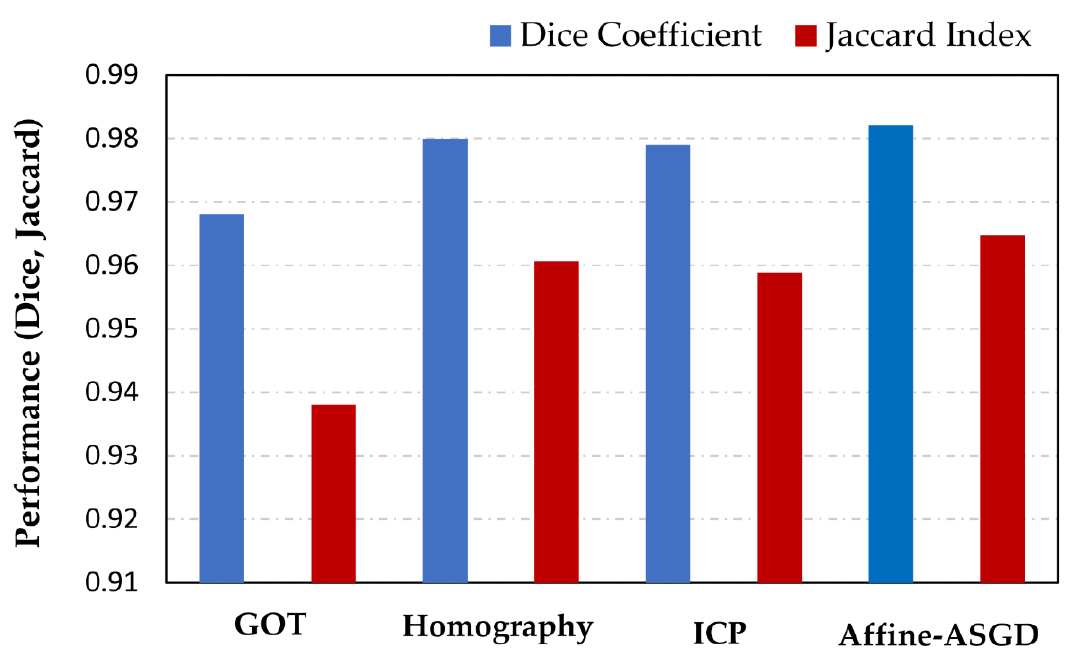
Figure 3. Dice coefficient and Jaccard index metrics for the four registration methods obtained with the subject located at the sensors focal plane (800 mm).